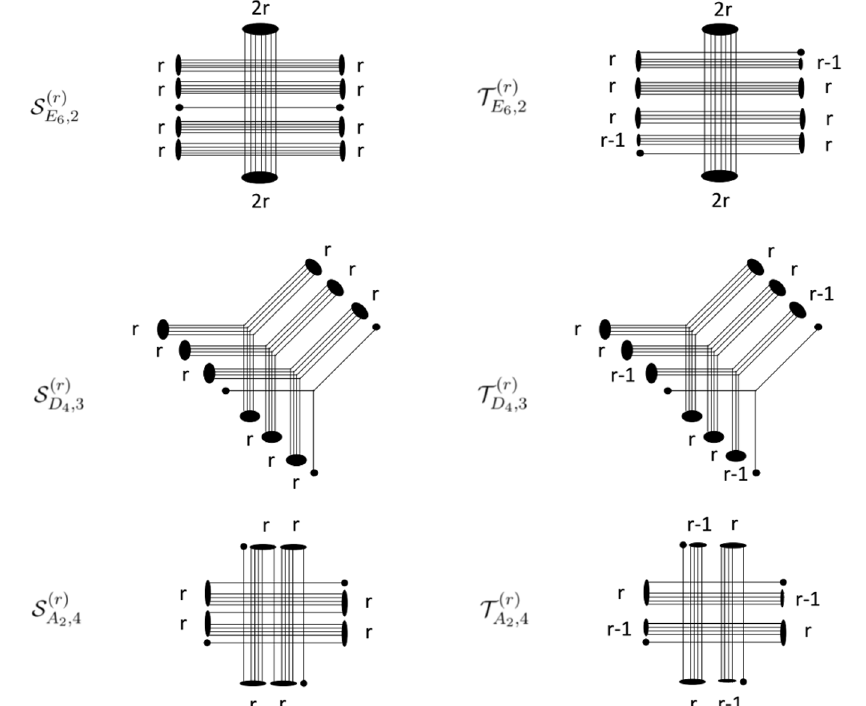
Figure 6. The brane webs describing the 5 d SCFTs whose twisted compacti(cid:12)cations yield the 4 d theories written to the left of the web. Here the black dots represent 7-branes of the type determined by the 5-branes ending on them. If bigger than 1, the number of 5-branes ending on each 7-brane is written next to the 7-brane. For the top two theories the compacti(cid:12)cation is done with a Z 2 twist corresponding to a (cid:25) rotation of the web and the SL(2 ; Z ) transformation (cid:0) I . For the two middle theories the compacti(cid:12)cation is done with a Z 3 twist corresponding to a 2 (cid:25) rotation of the 3 web and the SL(2 ; Z ) transformation ST (which is a symmetry of the web if the axiodilaton is set to the invariant value). For the bottom two theories the compacti(cid:12)cation is done with a Z 4 twist corresponding to a (cid:25) rotation of the web and the SL(2 ; Z ) transformation S . 2